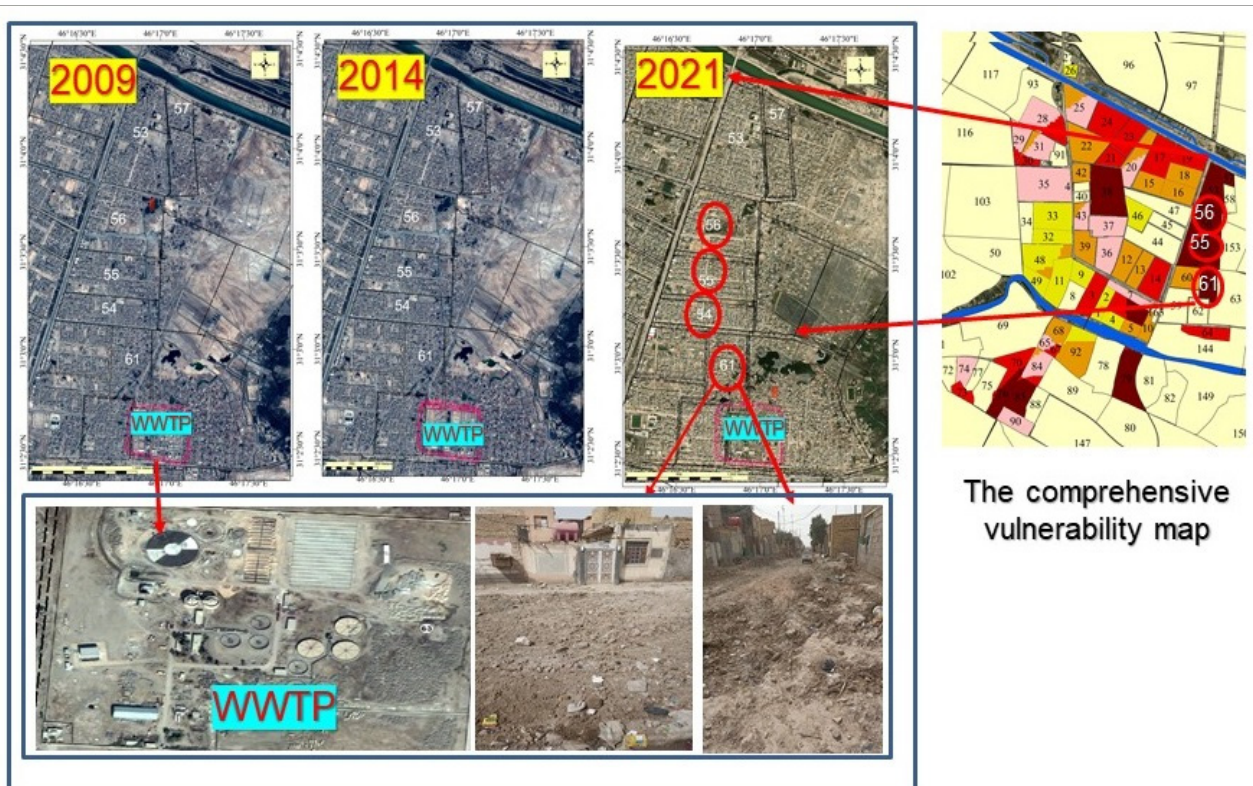
Figure 23. Spatial analysis process for the region with very high vulnerability.